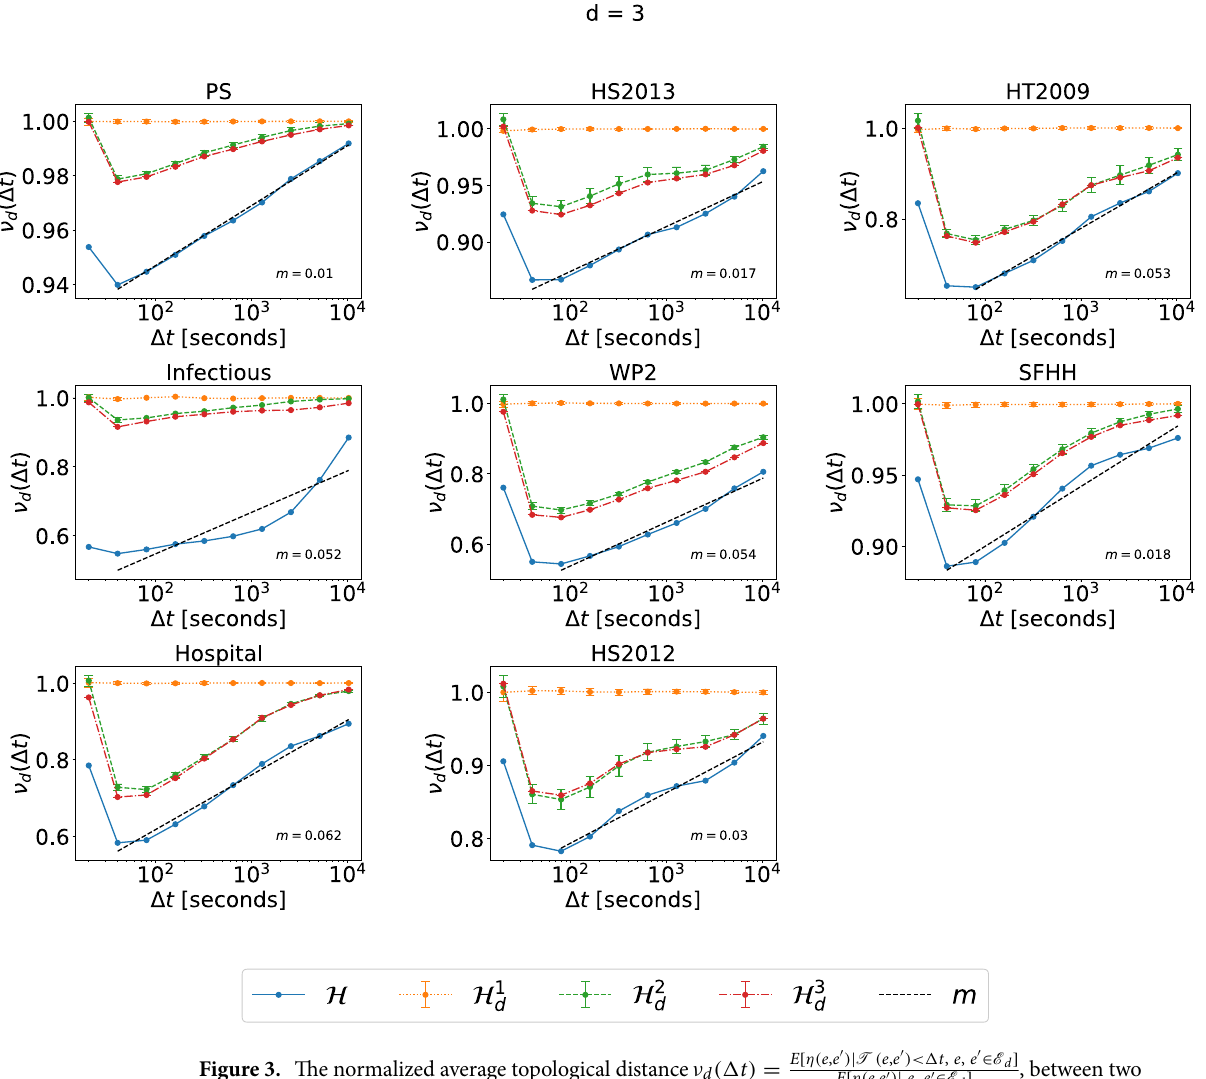
E [ η( e , e ′ ) | T ( e , e ′ )<� t , e , e ′ ∈ E d ] Figure 3. The normalized average topological distance ν d (� t ) = E [ η( e , e ′ ) | e , e ′ ∈ E d ] , between two order d = 3 events, in each physical contact network and its corresponding three randomized null models H 1 H 2 H 3 d = 3 events. d (yellow), d (green) and d (red), which preserve or destroy specific properties of order lim � , e ′ ) | T ( e , e ′ ) < � t , e , e ′ ∈ E , e ′ ) | e , e ′ ∈ E t →∞ E [ η( e d ] = E [ η( e d ] for any d . The horizontal axes are presented in logarithmic scale. The dashed line in each figure corresponds to the linear fit (with slope m ) of ν d (� t ) as a function of log 10 (� t ) in H , for the part that the curve has an increasing trend. For each dataset, the results of the three corresponding randomized models are obtained from 10 independent